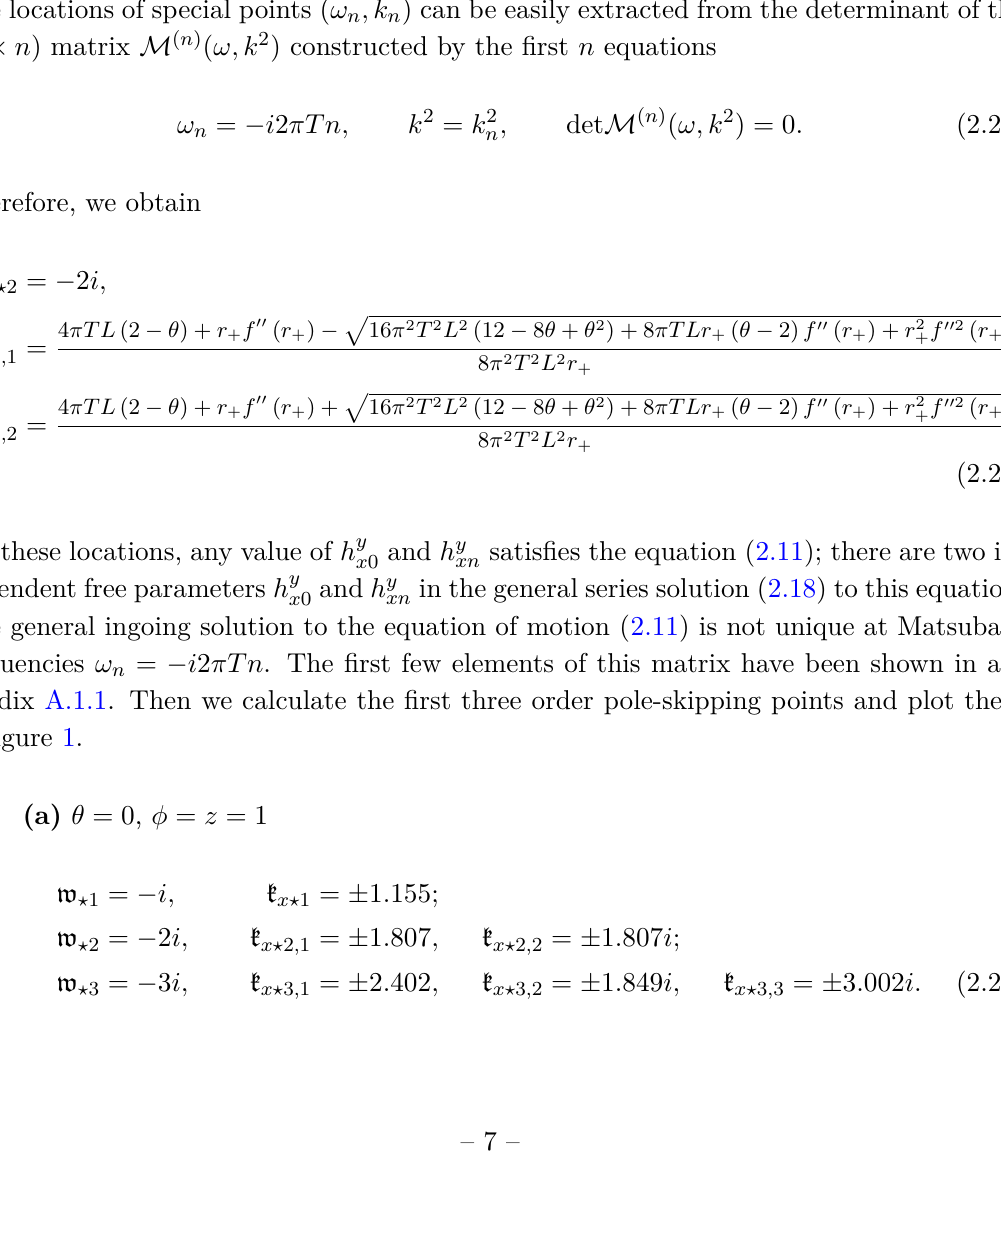
Figure 1 . The first three order pole-skipping points of tensor mode h y anisotropic system near Lifshitz points when a = 0 . (a) θ = 0 , z = φ = 1 ; (b) θ = − 3 , z = φ = 1